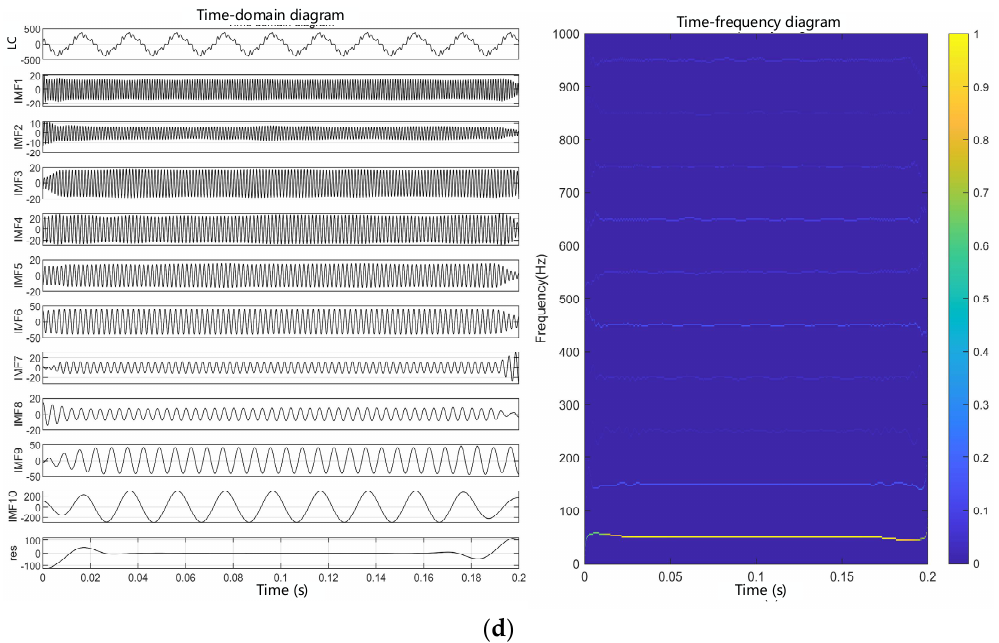
Figure 8. The time-frequency distribution of leakage current. ( a ) Unaged; ( b ) aging for 12 days; ( c ) aging for 24 days; ( d ) aging for 48 days